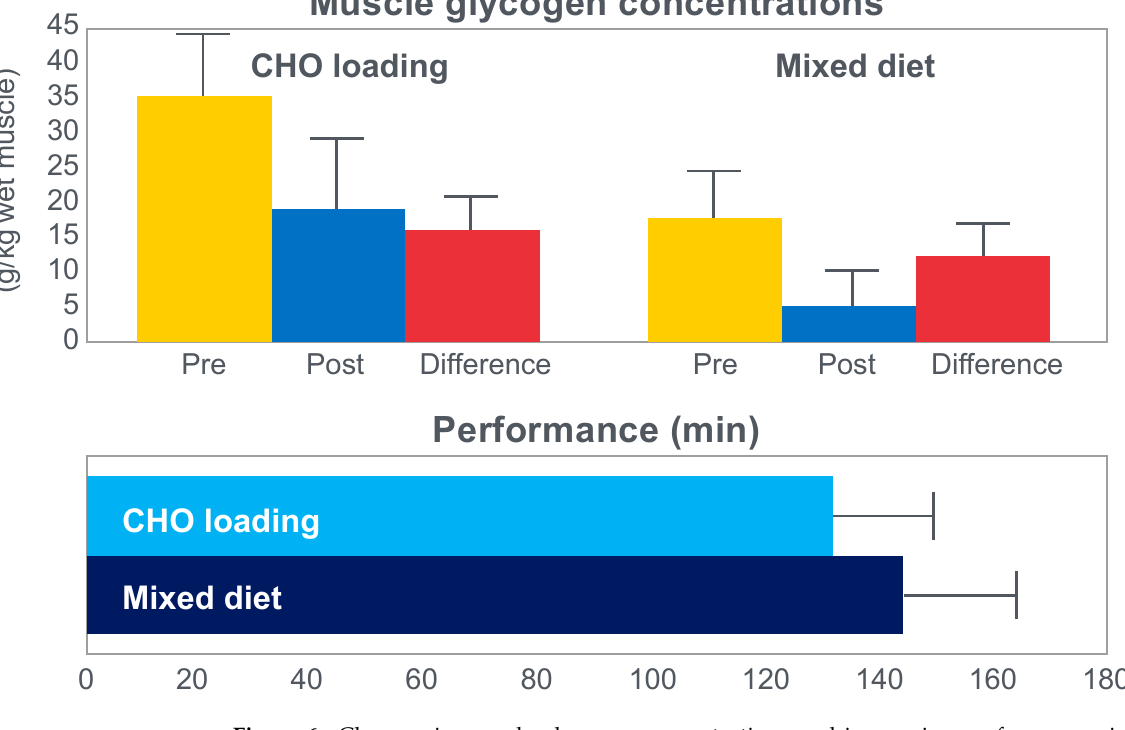
Figure 6. Changes in muscle glycogen concentrations and in running performances in athletes completing two 30 km races after high- (carbohydrate (CHO) loading) and mixed- carbohydrate diets. Drawn from data in [19].